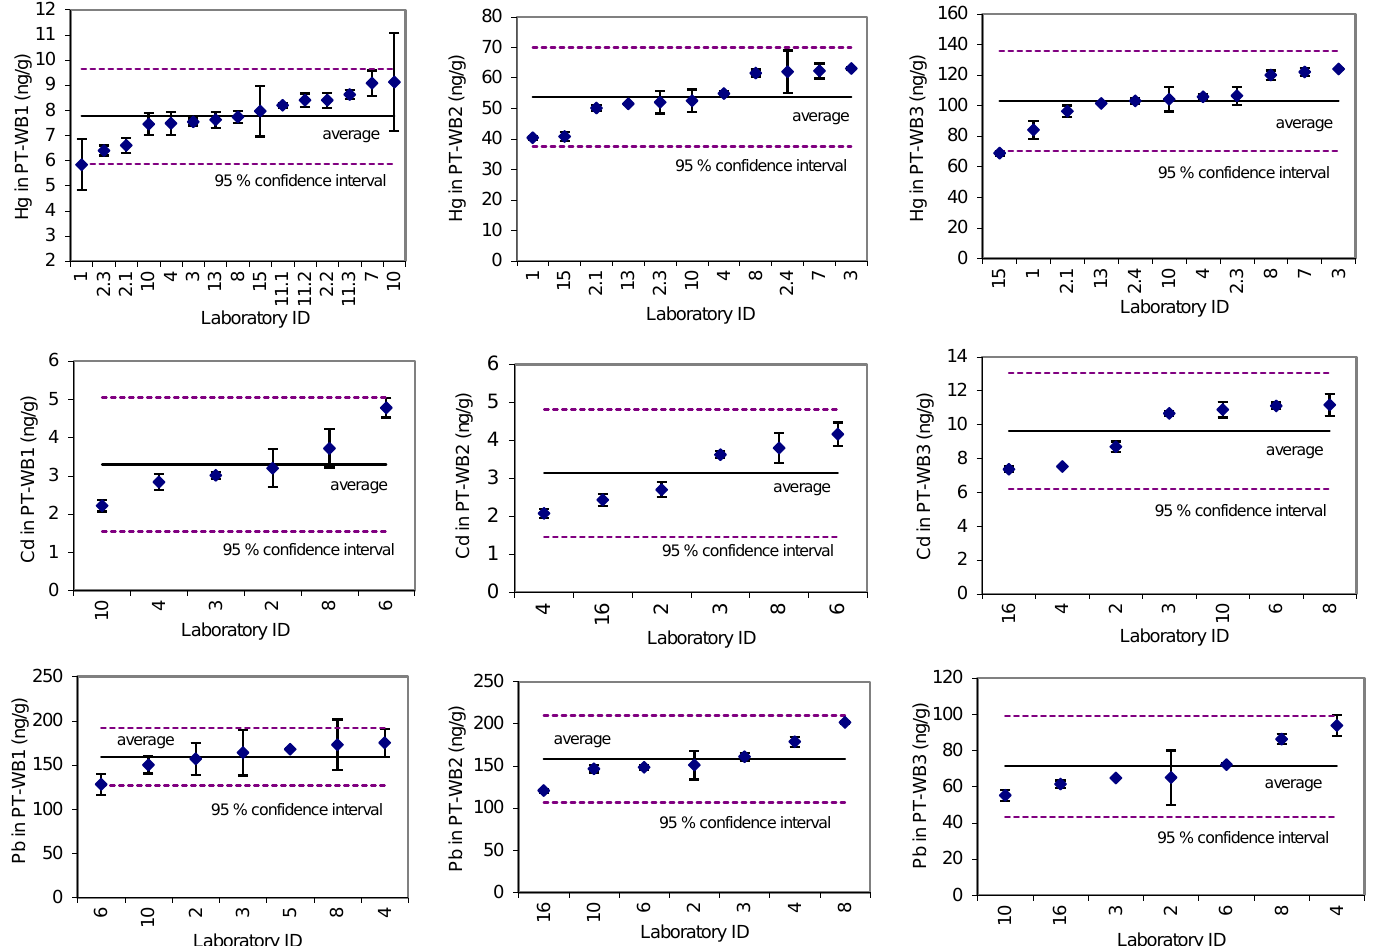
Figure 1. Total Hg, Cd, and Pb concentrations in the lyophilized ILC samples from the participating laboratories.